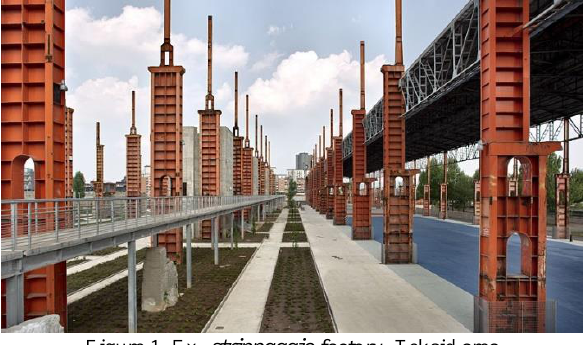
Figure 1. Ex- strippaggio factory, Teksid